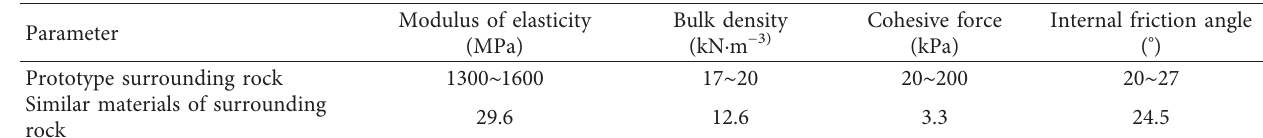
Table 7: Basic mechanical parameters of similar materials of surrounding rock.